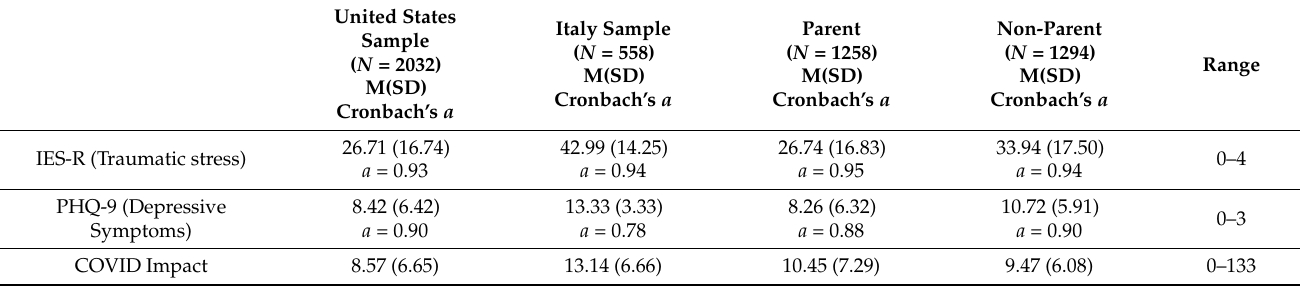
Table 2 for descriptive statistics by parental status and nationality. Table 2. Measure descriptive statistics by parental status and